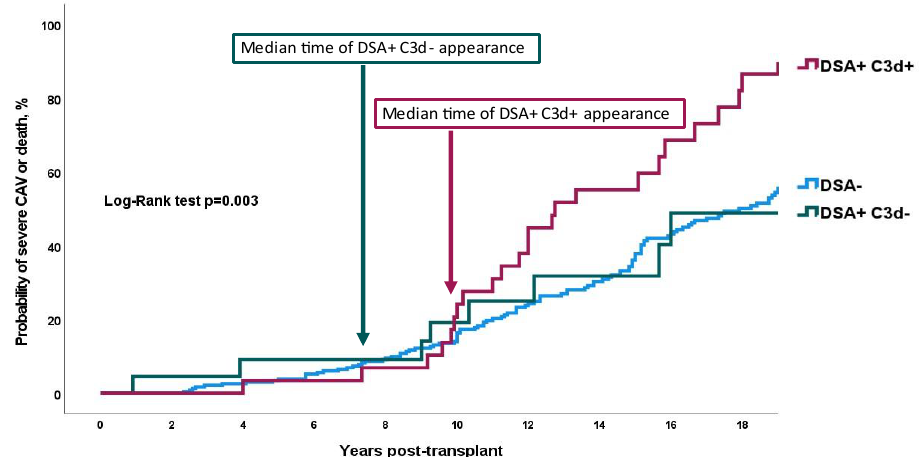
Figure 1. Probability of severe CAV or death according to DSA and C3d status. Log rank test p = 0.003. De novo C3d-binding DSA were associated with severe cardiac allograft vasculopathy and death. Non-complement-binding donor-specific anti-HLA antibodies were not associated with the risk of severe CAV or death. DSA = donor-specific anti-HLA antibodies; DSA+C3d+ = complement-binding donor-specific anti-HLA antibodies; DSA+C3d − = non-complement-binding donor-specific anti-HLA antibodies.